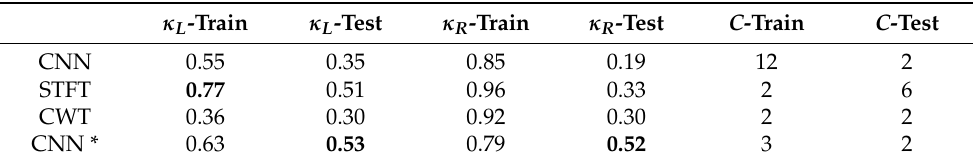
Table A2. Quantitative measures for the 12 h dataset. Significantly higher values in a column are in bold (chi-square test). κ indicates the kappa value for SVM; L indicates a linear kernel; R indicates a radial basis function kernel; C indicates the number of clusters by